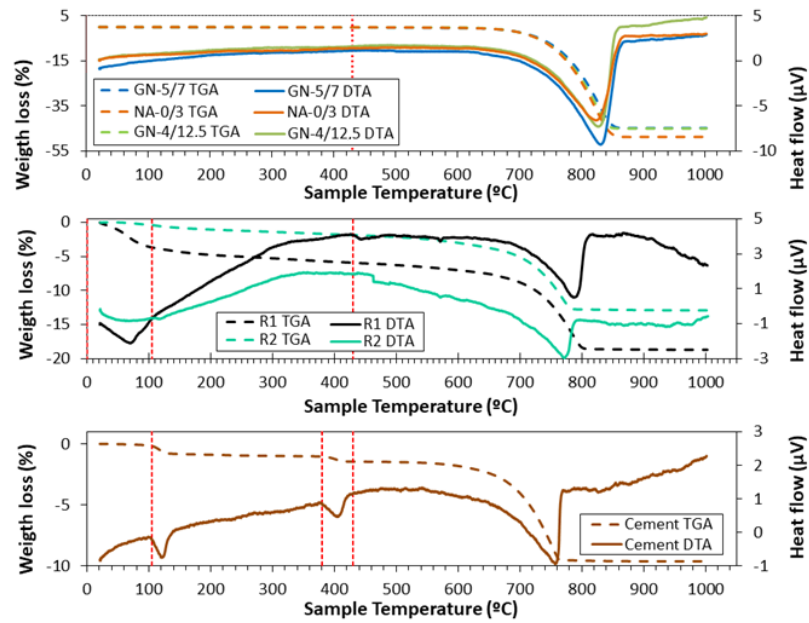
Figure 3. Thermogravimetric analysis (TGA) and differential thermal analysis (DTA) for starting materials. TGA (solid line) and DTA (dotted line).